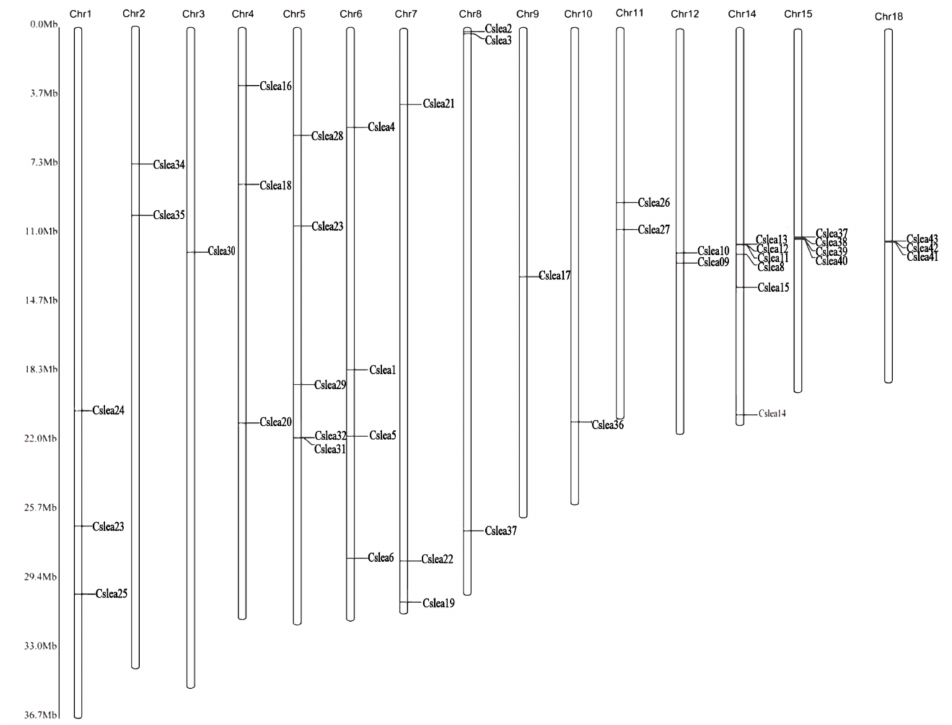
Figure 4. Locations of the 44 CsLEA genes on 15 chromosomes of C. songorica .